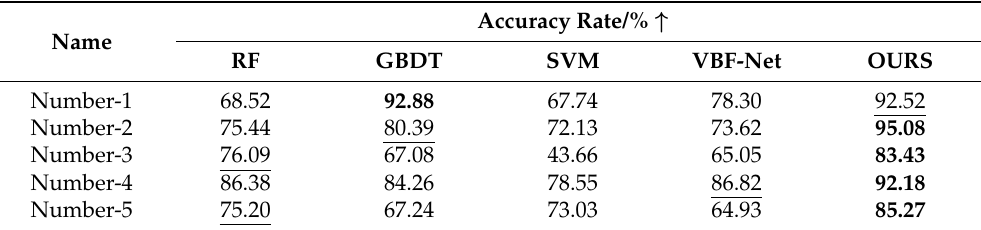
Table 4. Accuracy statistics of cable extraction for five groups of samples by different methods (bold indicates the optimal result, underline indicates the suboptimal result, the arrow pointing up indicates that the larger the value is, the better, and the arrow pointing down indicates the smaller the value is, the better).